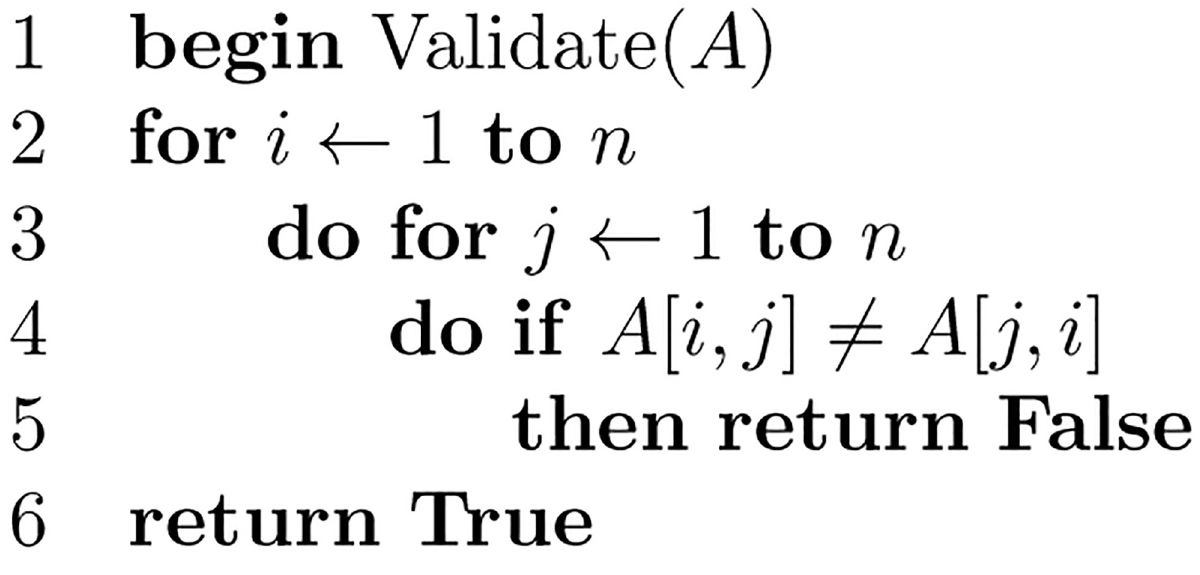
Fig 18. Algorithm to validate an n × n matrix A .